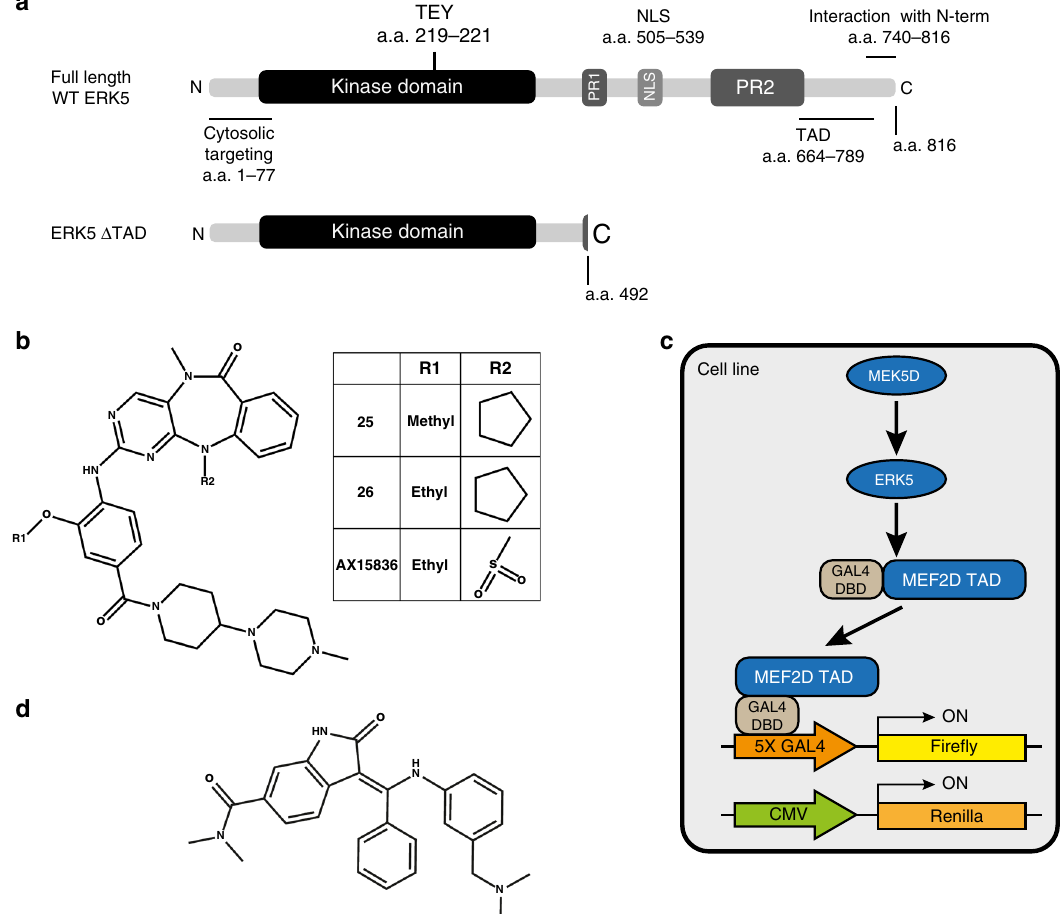
Fig. 1 Schematic diagrams of the reagents used in this study. a Schematic diagram of ERK5 (full length) and ERK5 Δ TAD, which lacks the C-terminal extension. Functional domains with amino acid positions are: cytosolic targeting domain (1 – 77), kinase domain (48 – 383), activation-loop TEY motif (219 – 221), proline rich domain (PR) 1 (434 – 485) and 2 (578 – 701), nuclear localisation signal (NLS) (505 – 539), minimal transactivation domain (TAD) (664 – 789), and the N-terminal interaction domain (740-816). b Chemical structures of ERK5i: compounds 25 , 26 and AX15836. c Schematic representation of the ERK5:MEF2D luciferase assay. d Chemical structure of the MEK5i, BIX02189. Structures were drawn using ChemDraw